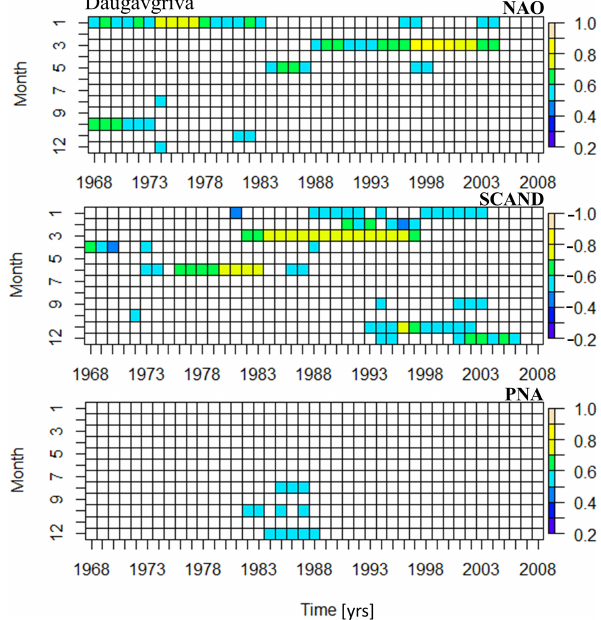
Figure 9. Sliding-correlation results for Daugavgr¯ıva and NAO, SCAND, and PNA climatic indices. The correlation is calculated for the water level monthly maxima with a window of 15 years. Only the correlation coefficients with a significance of more than 95% are